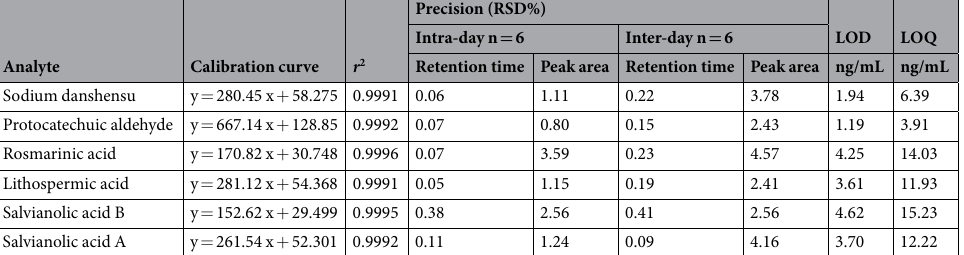
Table 1. Linear Regression Data, Precision, Limits of detection (LODs) and Limits of quantification (LOQs) of the Investigated Compounds